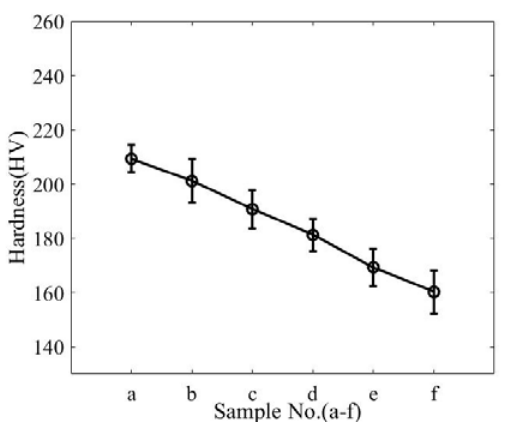
Figure 5. Variations in hardness for different specimens.